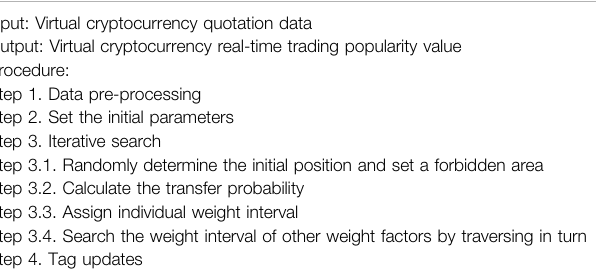
Algorithm 1 | Elite Ant Colony Algorithm Based on Mixed Parameters